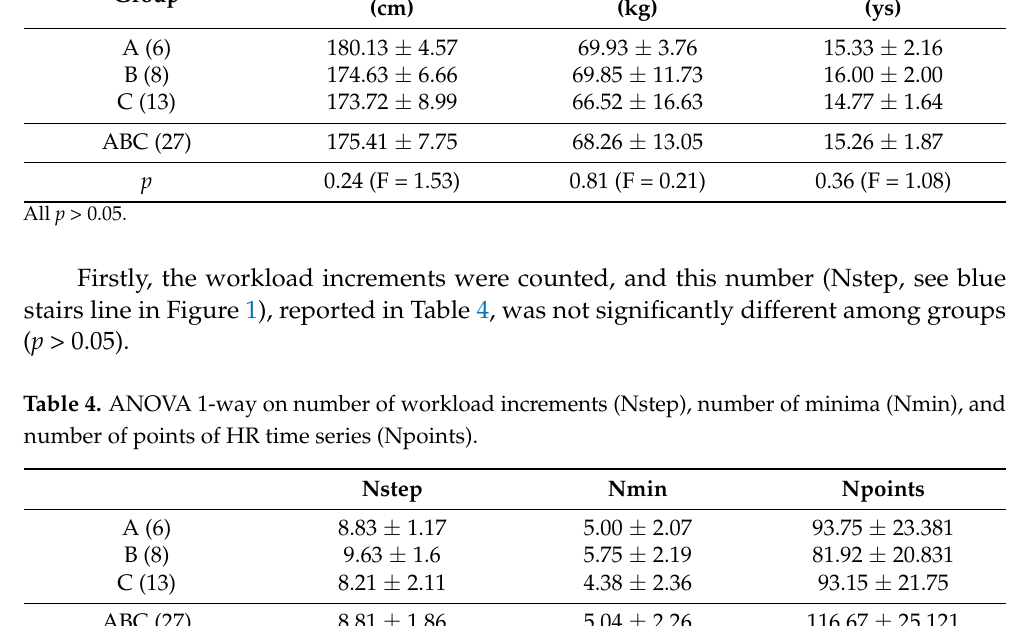
Table 3. ANOVA 1-way on age and anthropometric measures. Group